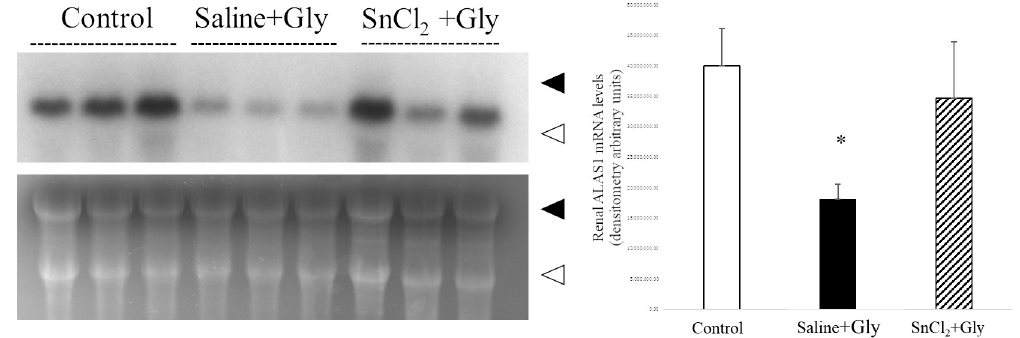
Fig 7. Expression of renal ALAS1 mRNA levels 3 h after Gly treatment. Rats pretreated with saline or SnCl 2 (s.c.) were sacrificed 3 h after Gly treatment (10 mL/kg of 50% glycerol, i.m.), and renal tissues were collected for northern blot analysis. Control, untreated control rats; saline+Gly, saline-treated before Gly-treated rats; SnCl 2 +Gly, SnCl 2 -treated before Gly- treated rats. Ethidium bromide staining of the same RNA is shown as a loading control. Closed arrowhead, 28S ribosomal RNA; open arrowhead, 18S ribosomal RNA. ALAS1 mRNA expression levels are expressed as arbitrary densitometric units. Data are expressed as the mean ± SD. � p < 0.05 vs control group.